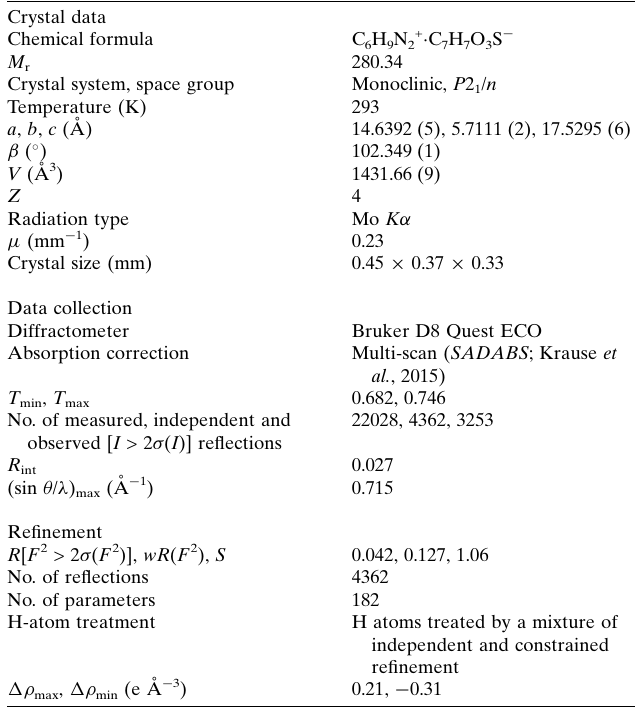
Table 2 Experimental